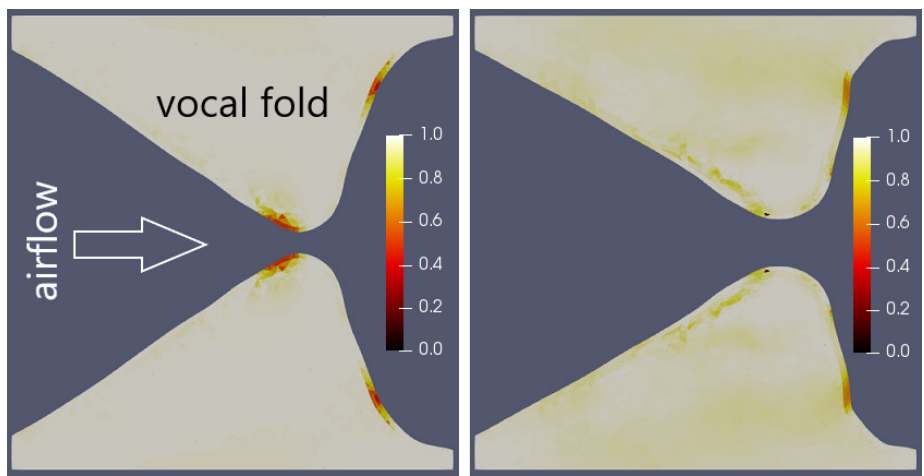
Figure 13. Details of VFs deformations and the ratios R of the norms of linear and nonlinear strain tensors for the smallest and the largest glottal gap. Computed by the St. Venant–Kirchhoff elasticity